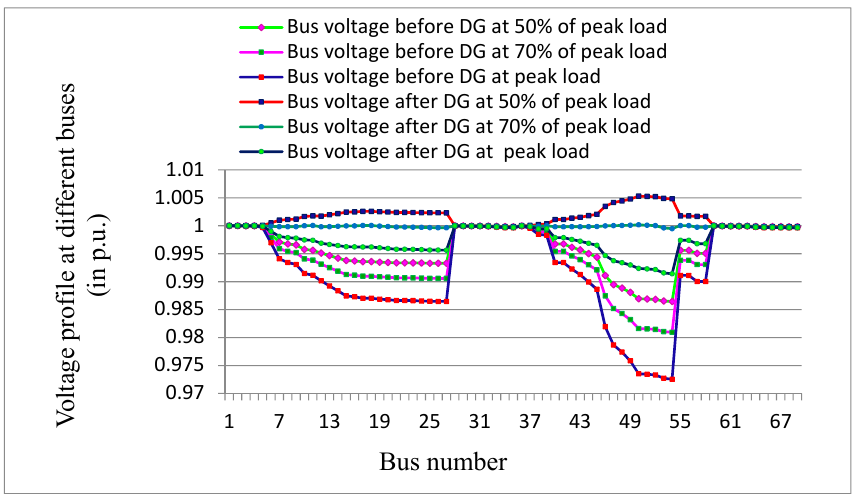
Figure 12. Voltage profile of IEEE 69-bus radial distribution network at different load levels before and after placement of DG unit.